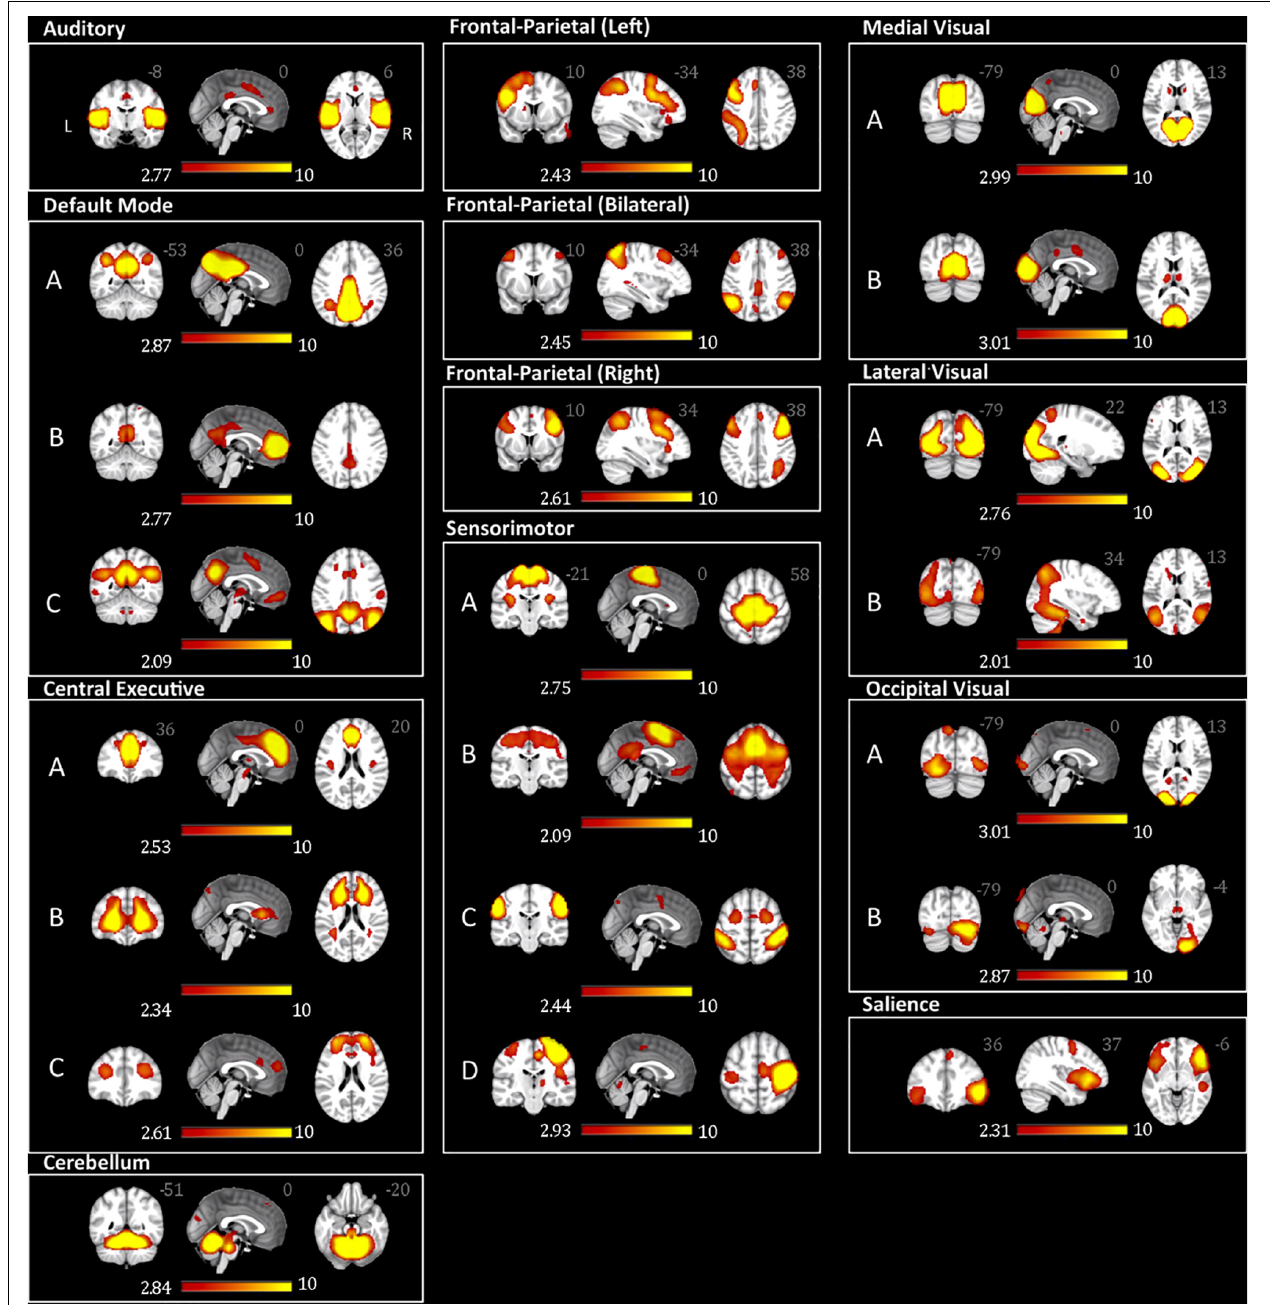
FIGURE 1 | Adolescents and young adults resting-state networks. The networks were obtained using probabilistic ICA on all participants as implemented in MELODIC. The figure depicts the 22 components (from the 75 ICs of the group ICA) selected for subsequent analysis based on the Pearson spatial correlation with previously defined resting-state networks (Smith et al., 2009 19620724) and visual inspection. These 22 components corresponded to 10 distinct resting-state networks. The resting-state networks are represented as z